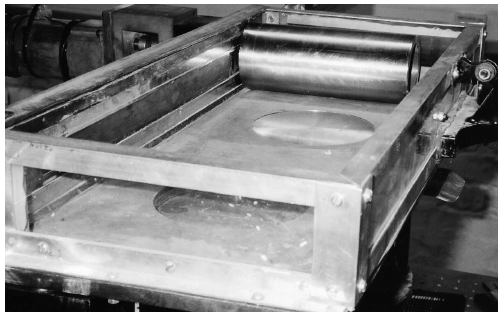
Figure 6. The build chamber showing a thin layer of powder presented as a single layer on a planar surface prior to direct photonic interaction.